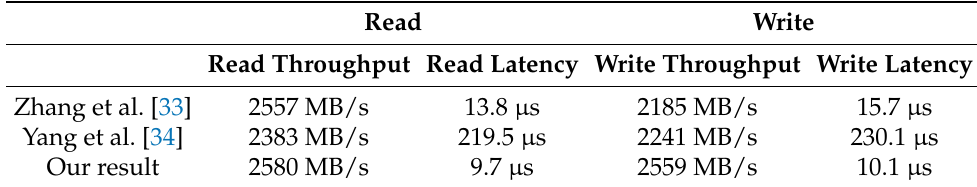
Figure 9. Experimental results of RAID 0 under multiple OSes and SSDs (S: sequential, R: random, Dev: number of devices). Table 2. Comparison to related